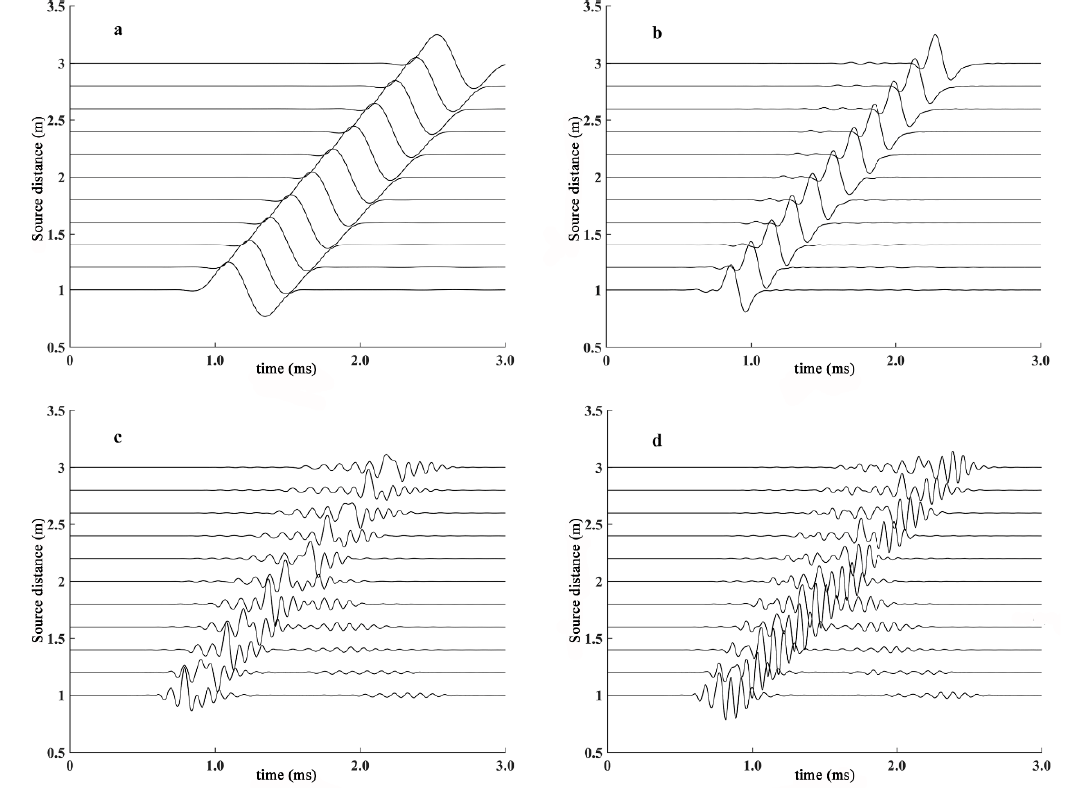
Figure 4. Borehole acoustic wave formed by different excitation frequency. Center frequency of source in ( a – d ) are 2 kHz, 5 kHz, 8 kHz and 10 kHz, respectively. Radius of the cave is 2 cm and the distance of the cave to the borehole wall is 2 cm.